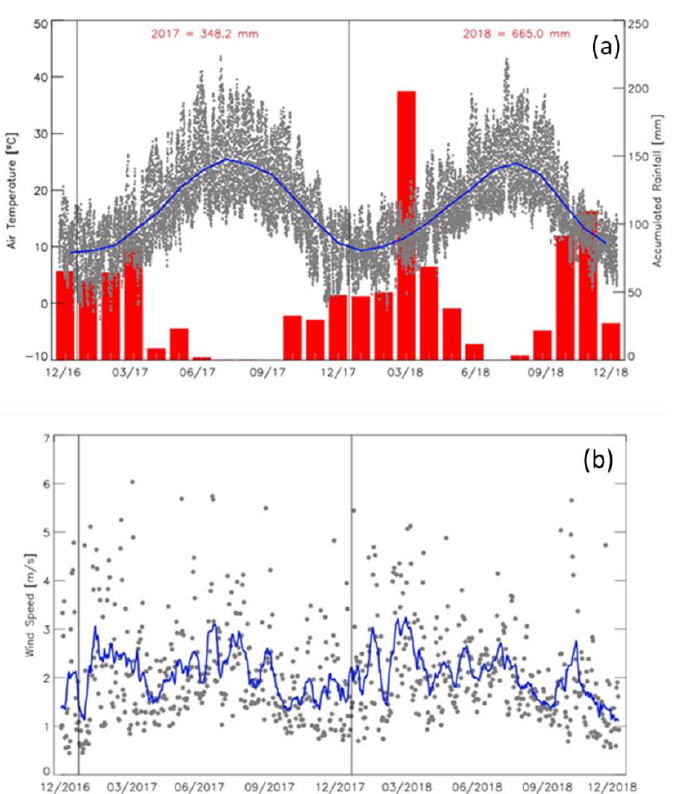
Figure 2. Meteorological charts from a station installed in the lower part of the Guadiana basin at the Alqueva reservoir shore in the period December 2016 to December 2018. ( a ) 1-min and monthly mean (grey dots and blue line) air temperature and monthly accumulated rainfall (red bars). The grey vertical line separates the years 2017 and 2018; ( b ) Daily and monthly mean wind speed (grey dots and blue line).